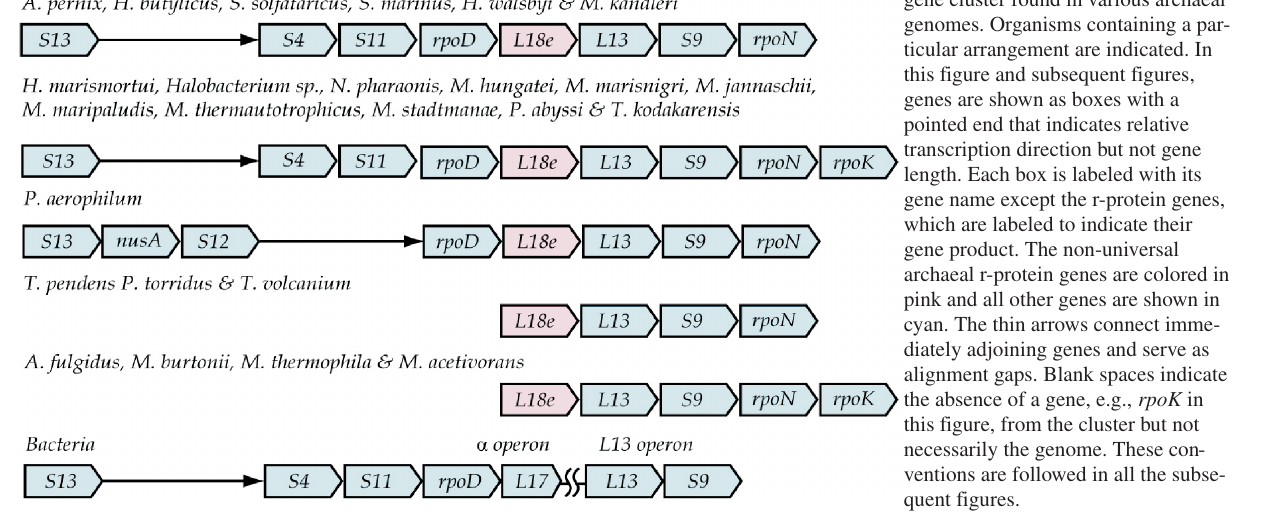
Figure 1. Aligned versions of the L18e gene cluster found in various archaeal genomes. Organisms containing a par- ticular arrangement are indicated. In this figure and subsequent figures, genes are shown as boxes with a pointed end that indicates relative transcription direction but not gene length. Each box is labeled with its gene name except the r-protein genes, which are labeled to indicate their gene product. The non-universal archaeal r-protein genes are colored in pink and all other genes are shown in cyan. The thin arrows connect imme - diately adjoining genes and serve as alignment gaps. Blank spaces indicate the absence of a gene, e.g., rpoK in this figure, from the cluster but not necessarily the genome. These con- ventions are followed in all the subse- quent